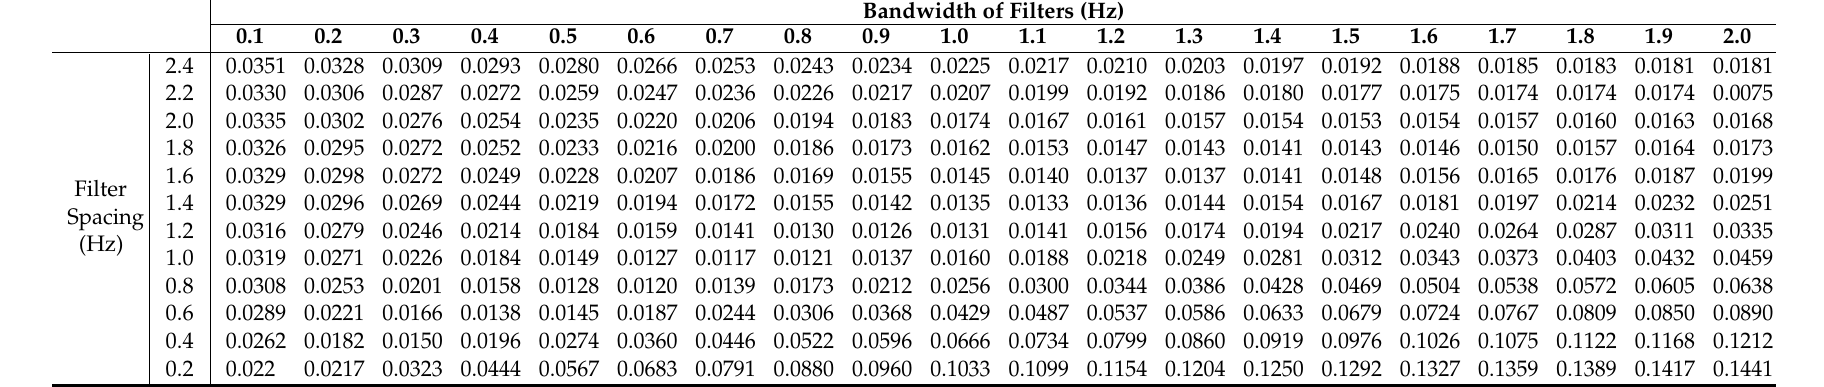
Table 1. RE values for a filter bank with 10